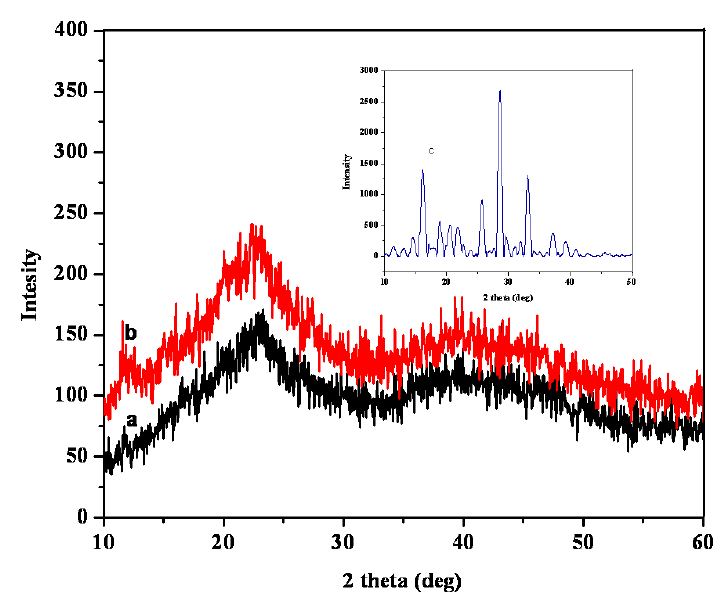
Figure 4. XRD patterns of PPK hydrogel for P2 formulation: (a) pure PPK hydrogel, (b) 5-FU-PPK hydrogel, and (c) 5-FU.